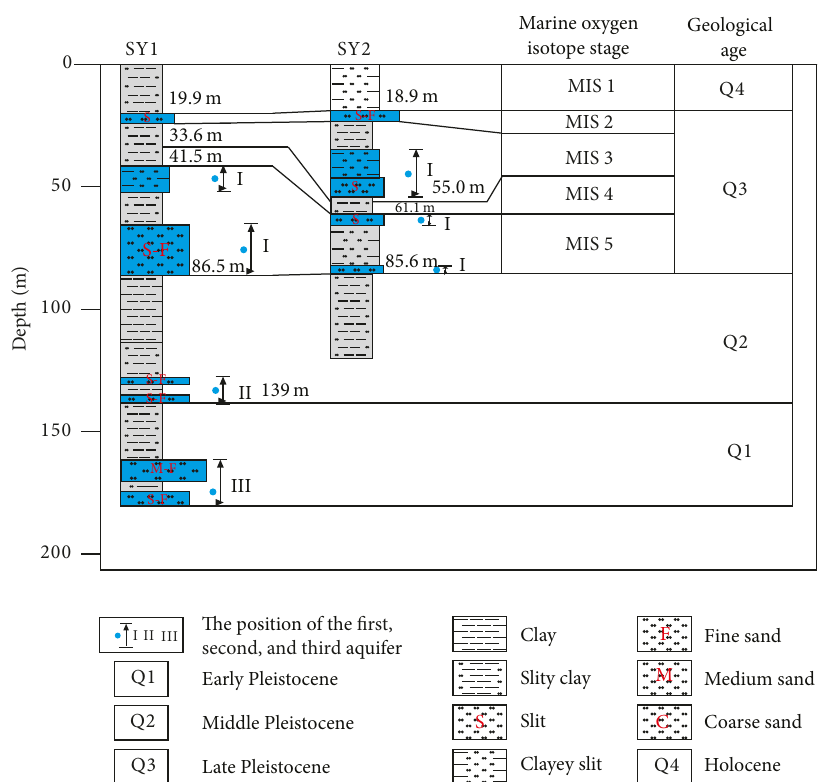
Figure 3: Geological profiles, time periods of the drilled boreholes in NJCP, along with hydrostratigraphic interpretation. The marine oxygen isotope stages are determined by the marine micropaleontology identification. I, II, and III represent the positions of first, second, and third confined